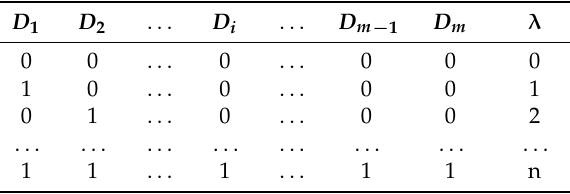
Figure 11. DS (up) and GOOSE Control Block (down)